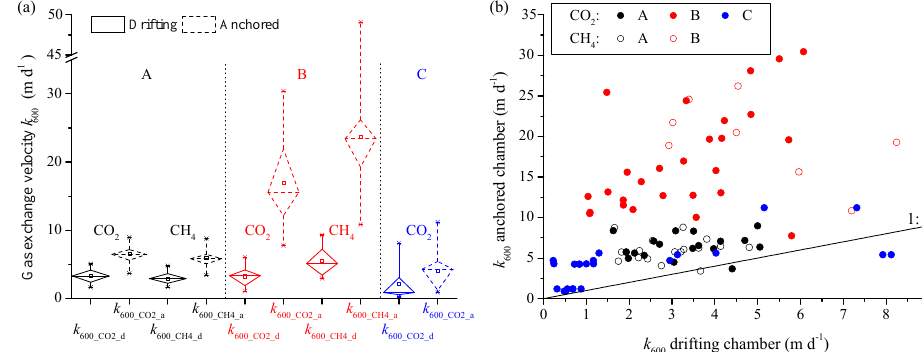
Figure 1. (a) Box plots of the standardized gas exchange ( k 600 ) velocity measured using drifting (solid lines) and anchored (dashed lines) flux chambers in data set A (black), B (red), and C (blue). The diamond-shaped boxes encompass the 25–75 percentile range, whiskers show minimum and maximum, and open squares and horizontal lines mark mean and median values, respectively. (b) k 600 estimated from anchored chamber deployments versus that from drifting chambers for the data sets A–C (see color code in the inset.). Filled symbols show k 600 estimated from CO 2 fluxes; open symbols are based on CH 4 fluxes. The solid line shows a 1:1 relationship.